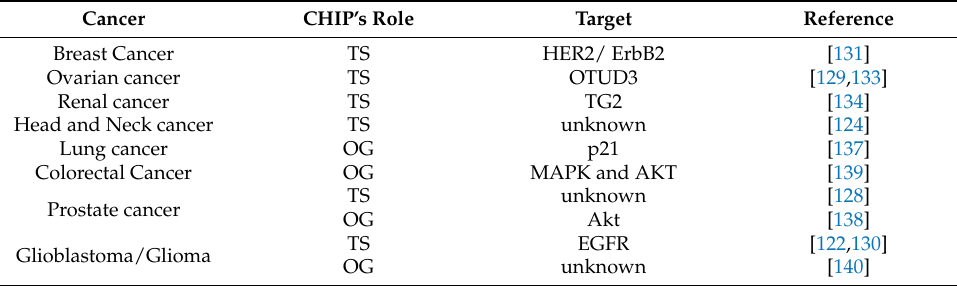
TS = tumor suppressor, OG =